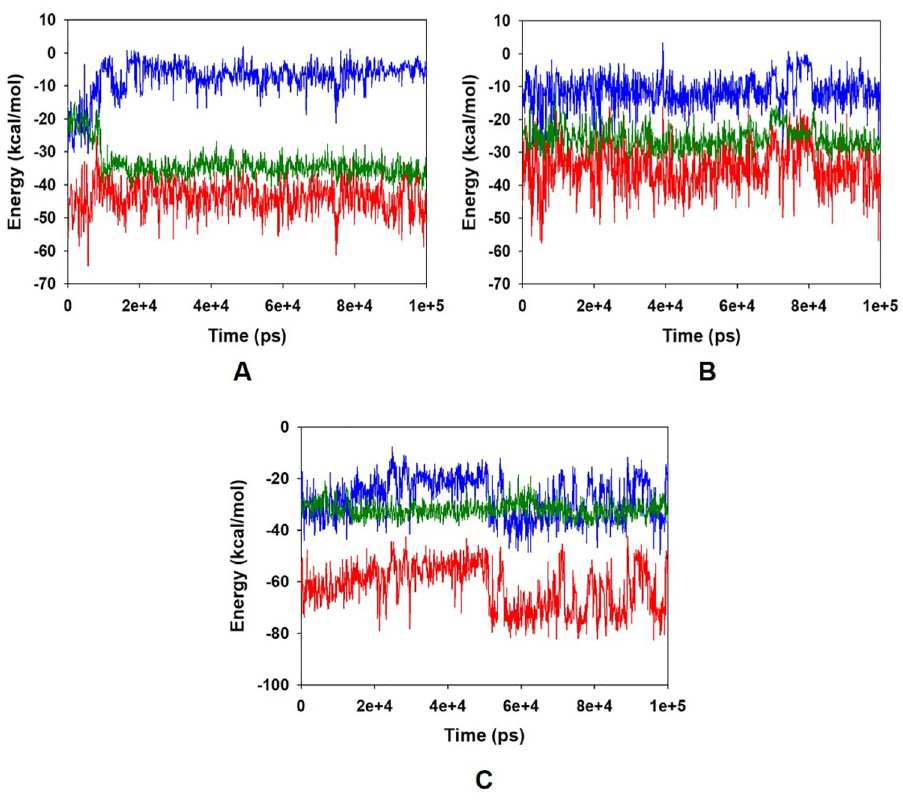
Fig 4. Energy plot of protein (A) BCL-2 (B) JAK2 and (C) Cyp2E1 and quercetin complex system during the entire simulation event of 100 ns. The total energy (red), van der Waal’s energy (green) and coulomb energy (blue) of the entire system indicating the stability of the individual systems bound to quercetin